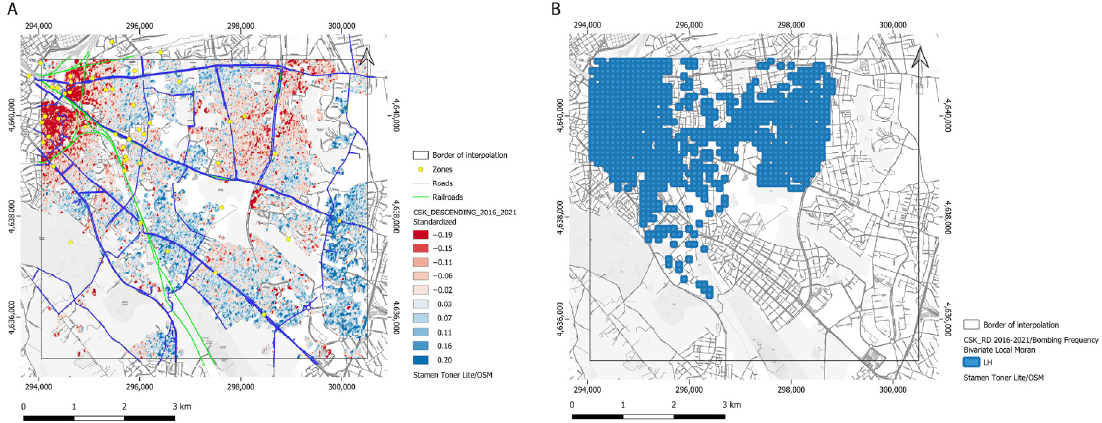
Figure 14. ( A ) Standardized velocity map (CSK_ASC) and targets of the most relevant air strikes (Roads, Railways and strategic areas in Zones); ( B ) hotspot map calculated with the Bivariate Local Moran tool to visualize the correlation between the subsidence values recorded in the CSK-RD velocity map (cold clusters) and the higher bombardment frequencies (hot clusters) in the Low/High (LH) class, shown in the picture as blue cells.